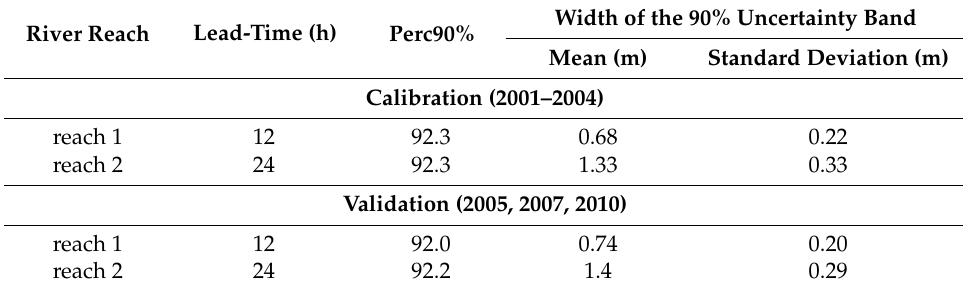
Table 5. As for Table 3, but considering a separated calibration and validation dataset for MCP-MT. River